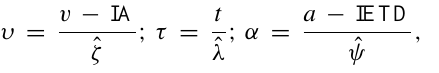
the standard deviation, leading to the reduction of the coeffi- cient of